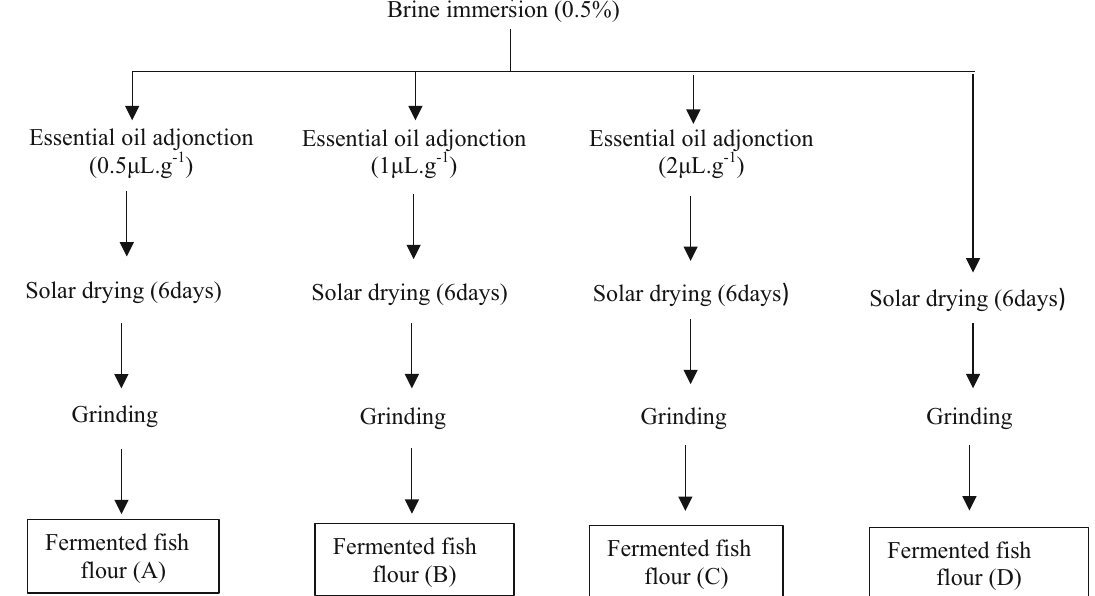
Fig. 1 Process diagram of different fermented fish flours